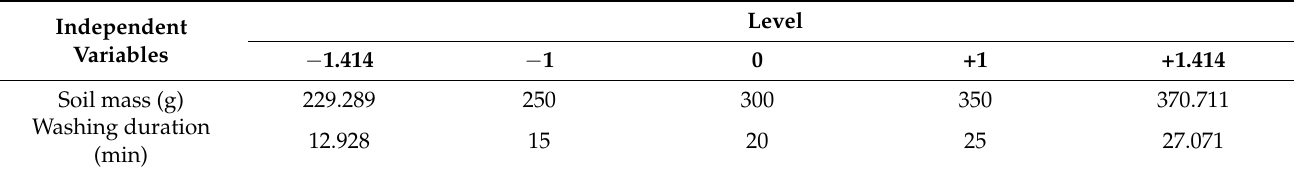
Table 5. Variables and levels considered in the CCD 2 2 factorial design. Decoded